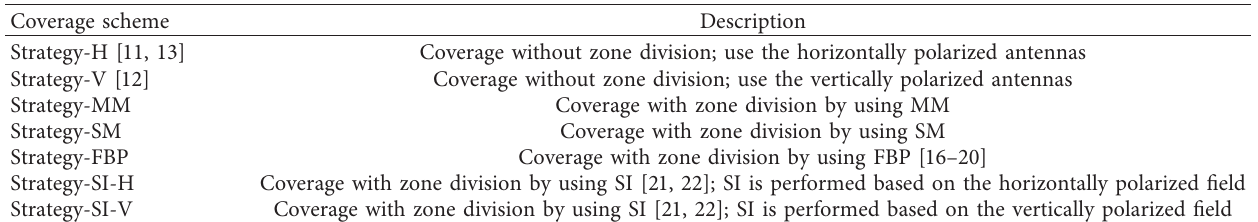
Table 8: List of coverage schemes for